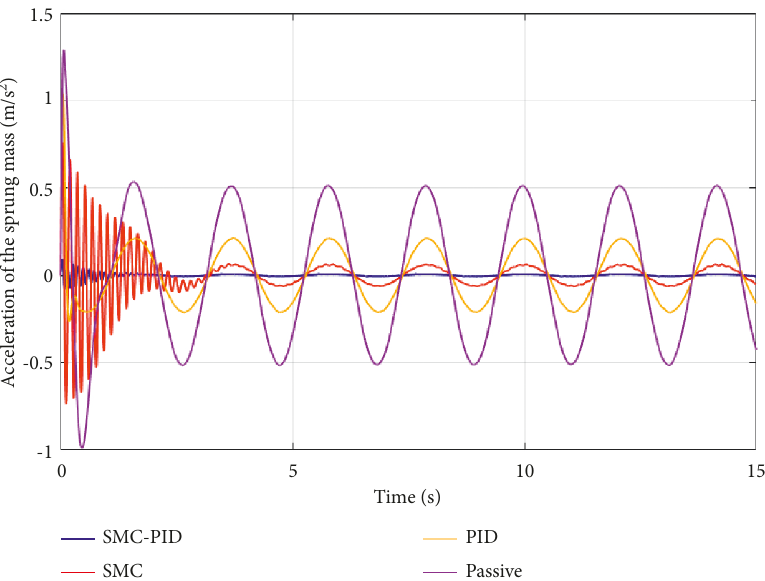
Figure 5: Acceleration of the sprung mass (Case 1).